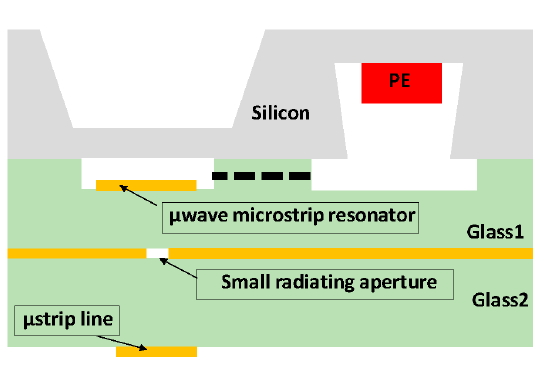
Figure 1. Previous dosimeter design.